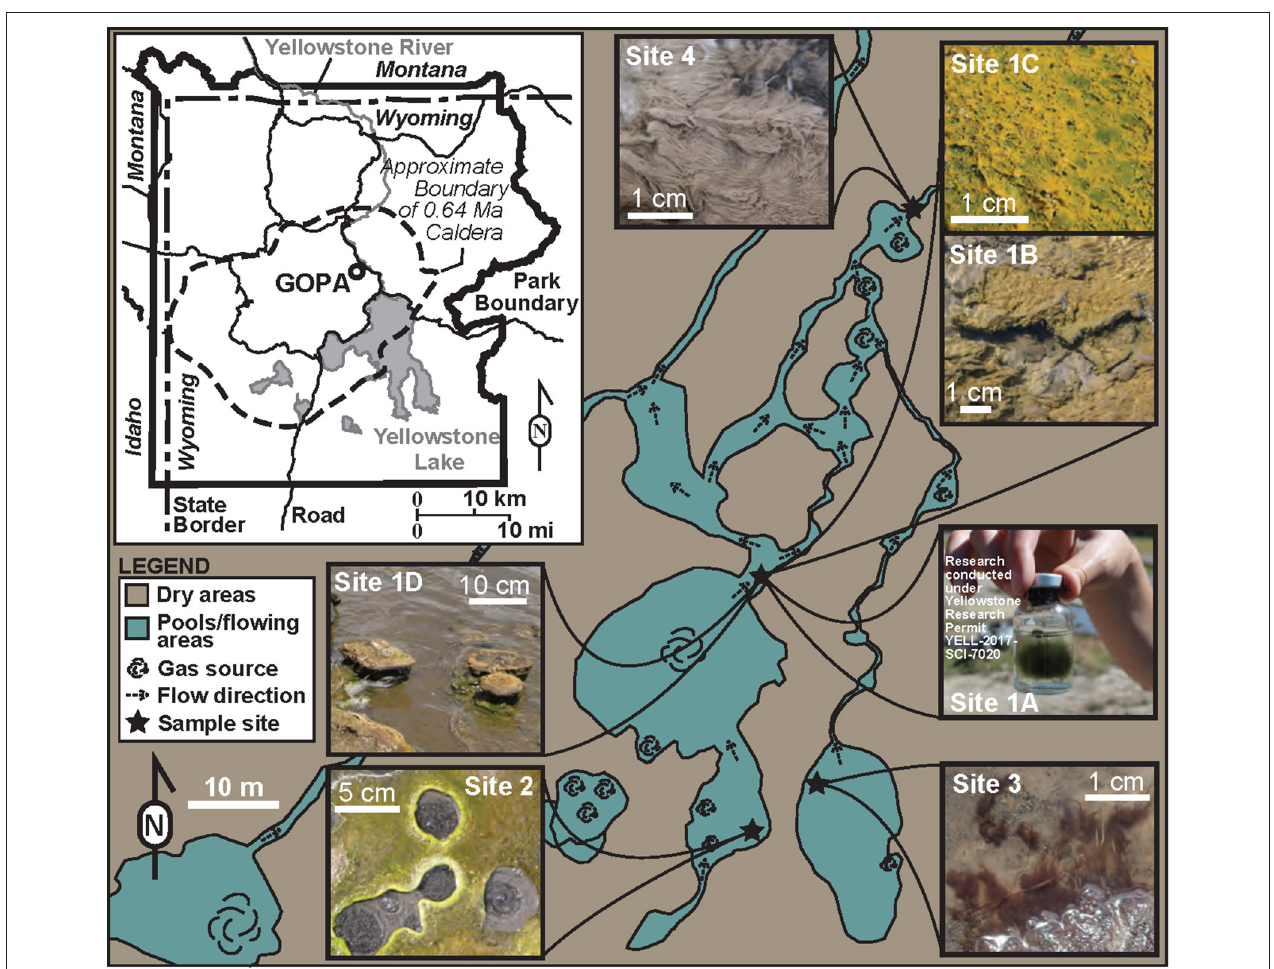
FIGURE 1 | Map of Yellowstone with zoom in of GOPA showing sample locations and